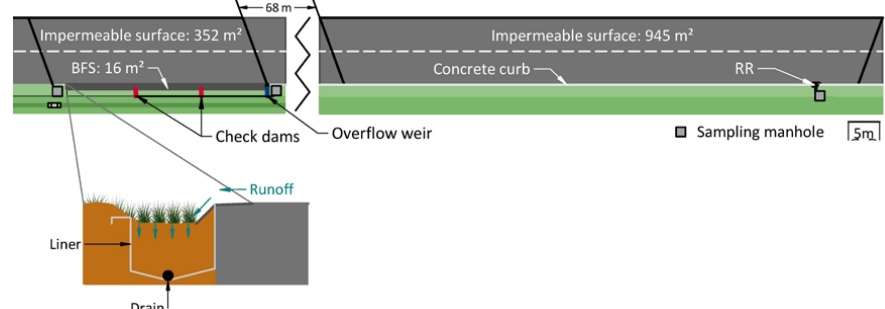
Figure 1. The Compans experimental